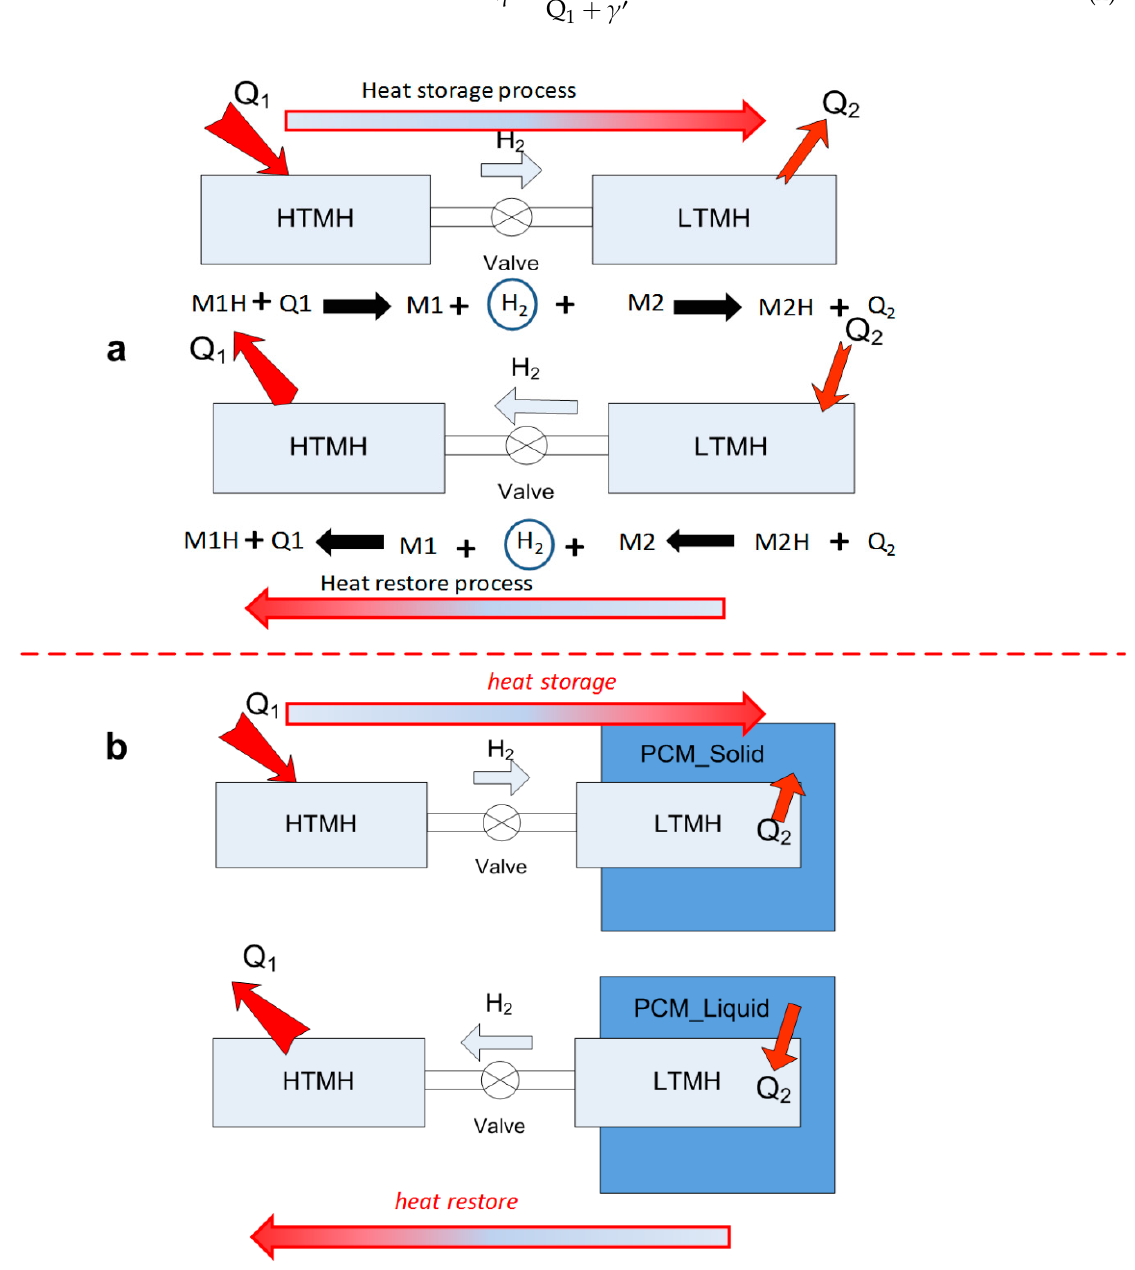
Figure 2. Two-tank thermochemical thermal energy storage (TES) utilizing metal hydrides pair: ( a ) conventional system; ( b ) Proposed storage system using phase change materials (PCM) for internal heat recovery.